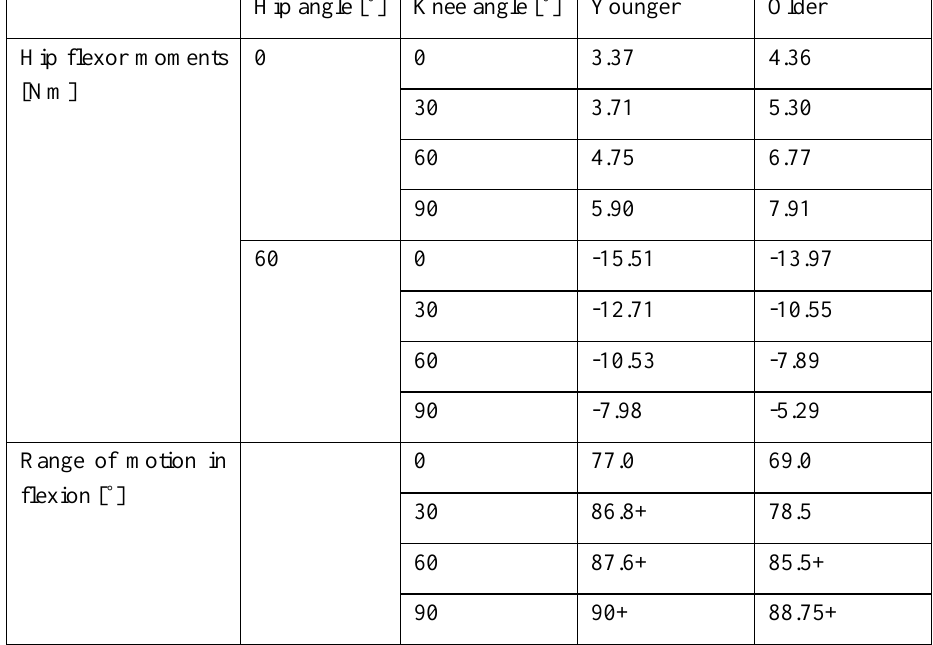
Table 1 Peak resisting moments at the hip and the range of motions derived from the moment-flexion curves are listed. The peak resisting moments were selected when the hip in 0 degrees and 60 degrees in flexion. “+” signs mean some of the subjects exhibited over 90 degrees of the range of motions in flexion. * Significant at